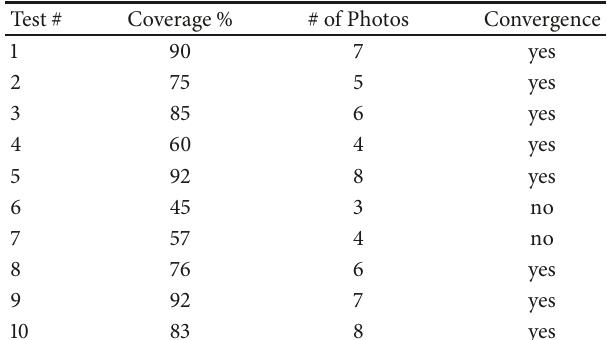
Table 1: Navigation, convergence, and photo taking experiments.